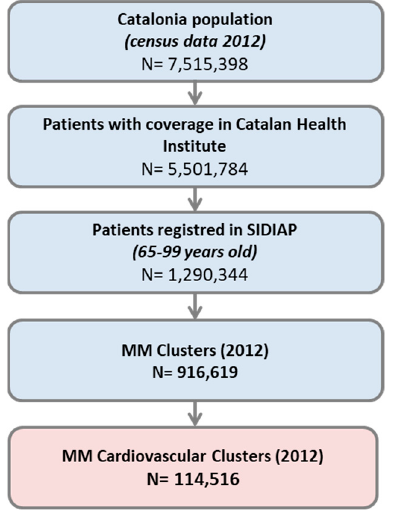
Figure 1. Estimated population study according to selection criteria.